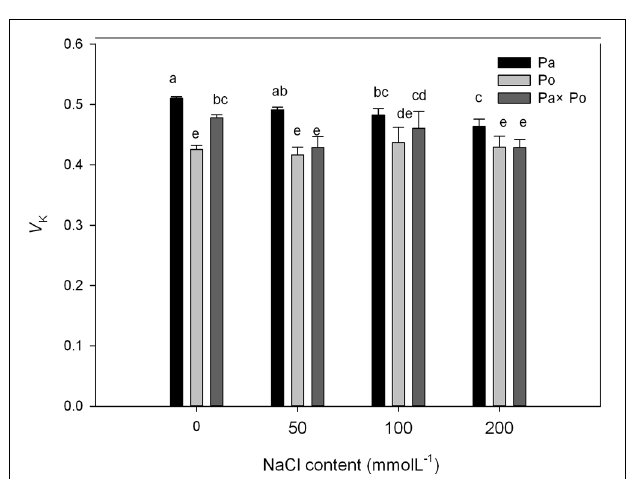
FIGURE 9 | The effect of salt stress on the standardized O–K curves and V L of leaves from three P. amurensis sample groups. Pa, P. amurensis Maxim ( Po, P. opulifolius “Diabolo” ( ); Pa × Po, P. amurensis Maxim ( ) × P. opulifolius “Diabolo” ( ). Data in the figure are mean ± SE; values ♂ followed by different lowercase letters indicate a significant difference ♀ ♂ ( p <